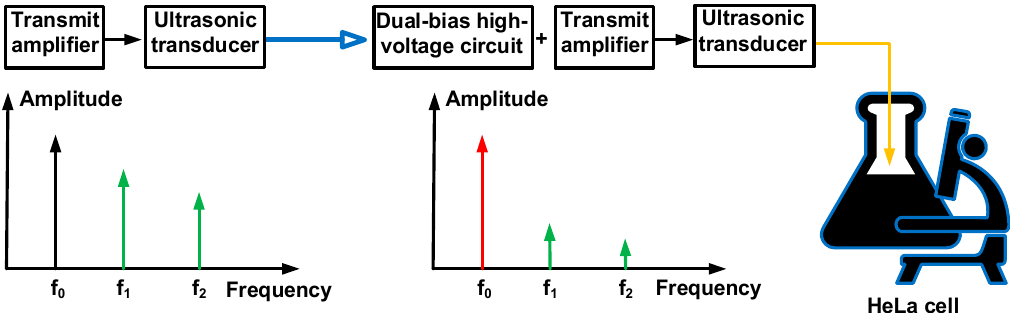
Figure 1. Concept of dual-bias high-voltage circuit and transmit amplifier for HeLa cell therapeutic effects.